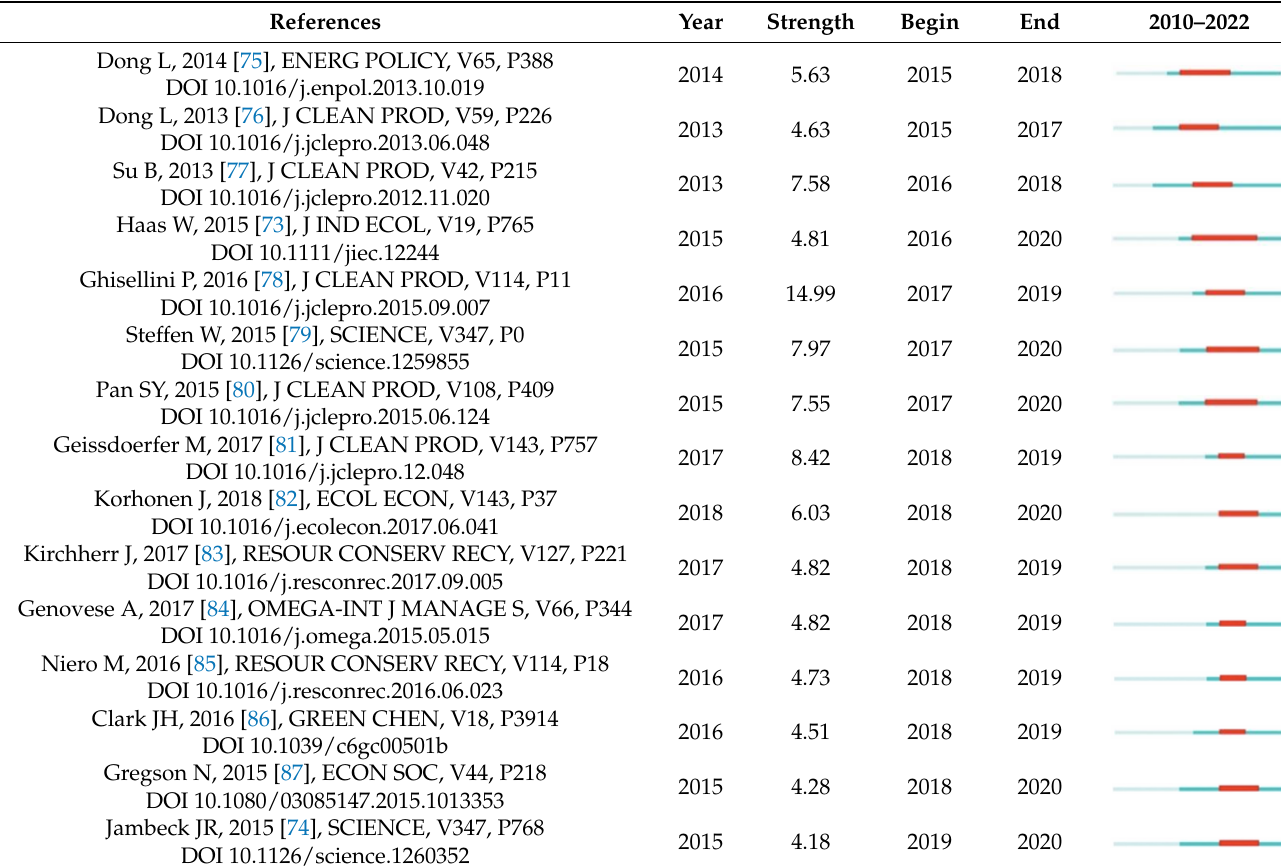
Table 5. Top 15 references with the strongest citation bursts.